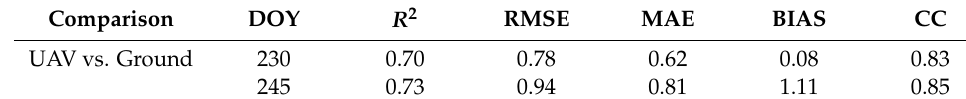
Table 8. Statistical performance of Landsat 8 with ground measurements.